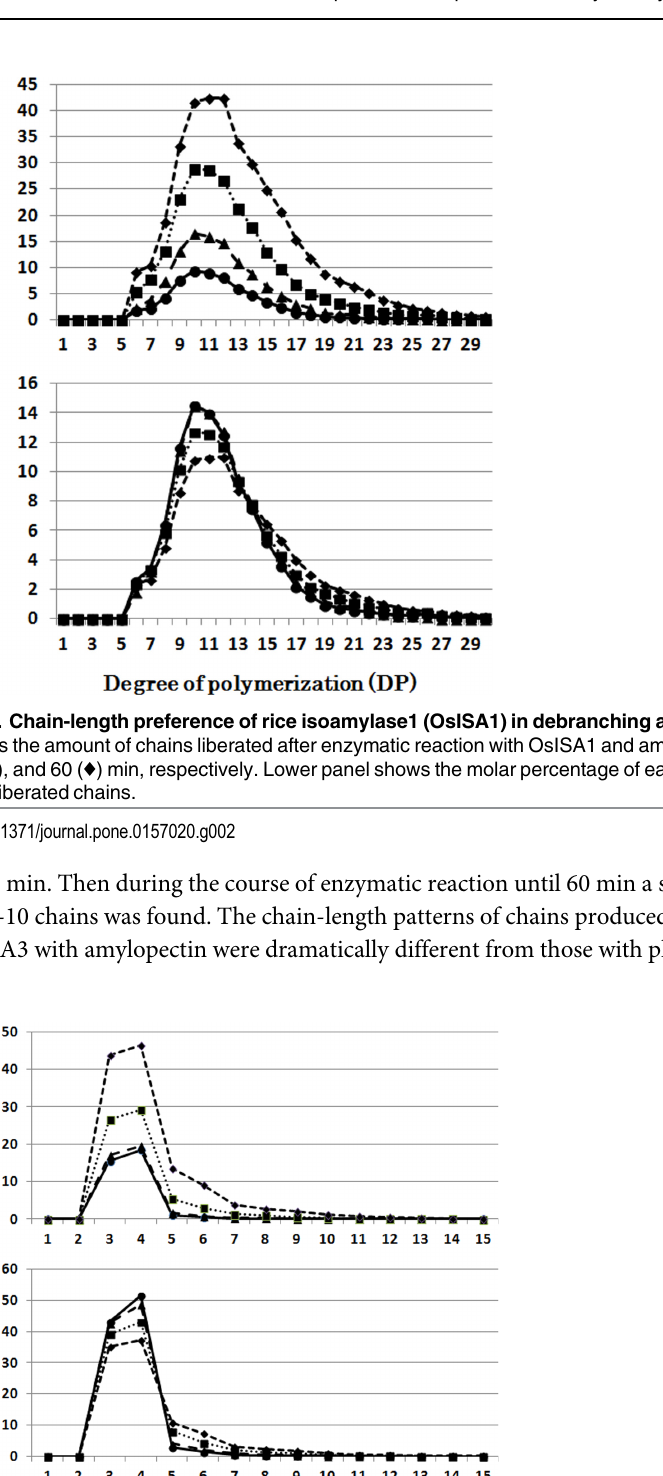
Fig 3. Chain-length preference of rice isoamylase3 (OsISA3) in debranching phytoglycogen. Upper panel shows the amount of chains liberated after enzymatic reaction with OsISA3 and phytoglycogen for 5 ( ● ), 10 ( ▲ ), 30 ( ■ ), and 60 ( ♦ ) min, respectively. Lower panel shows the molar percentage of each liberated chain to the total liberated